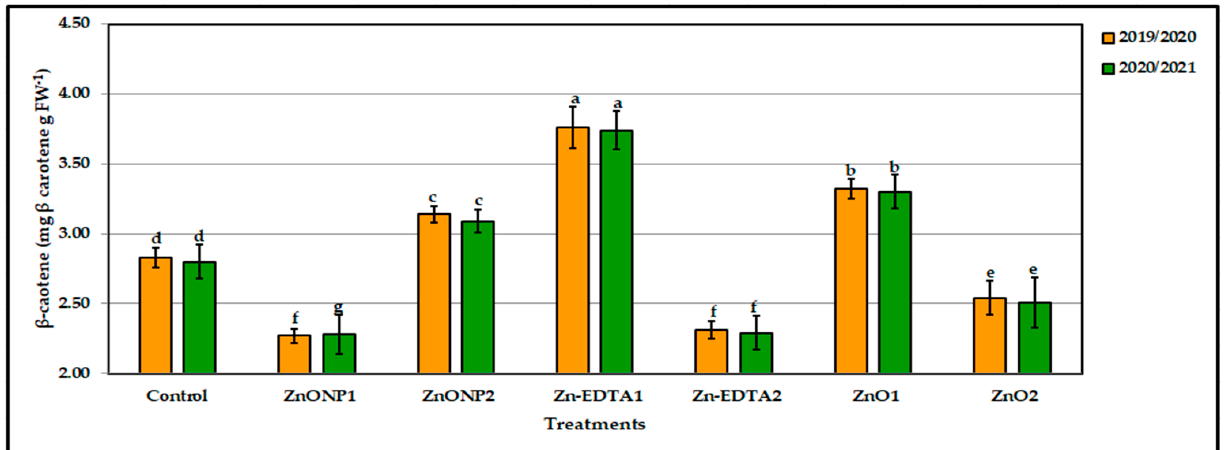
Figure 2. Influence of exogenous foliar application with some different zinc forms on anti-radical power (ARP) of root carrot grown under zinc-deficit stress in 2019/2020 and 2020/2021 growth seasons. Bars with a different letter indicate significant difference between treatments at p ≤ 0.05.